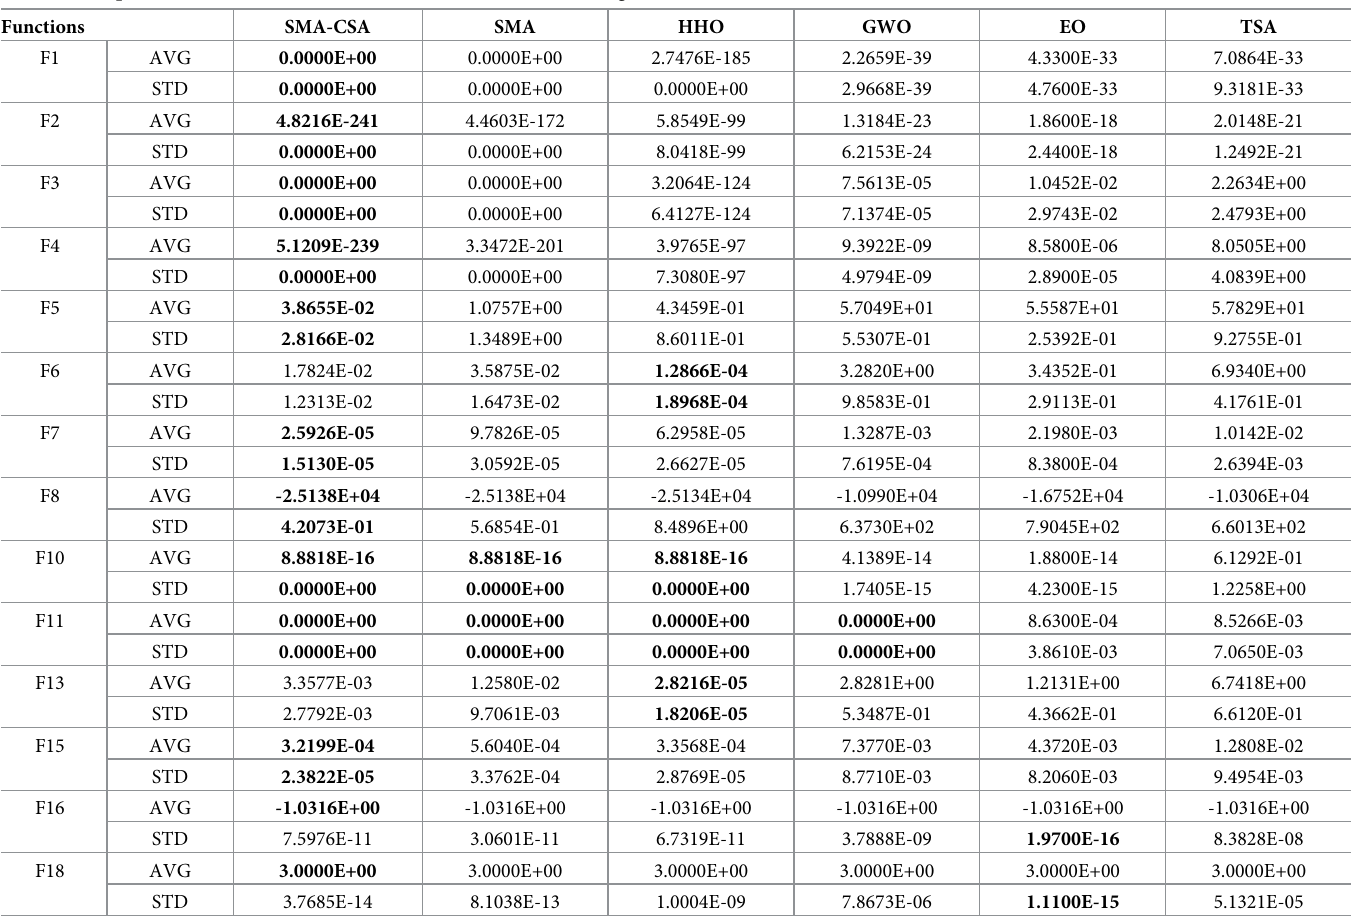
Table 6. Comparison of benchmark function results between traditional algorithms with 60 dimensions.